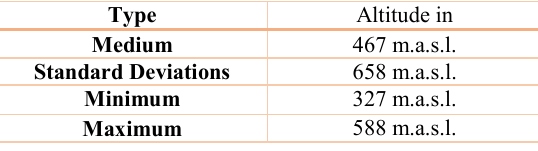
Table 1. Altitude of monasteries.